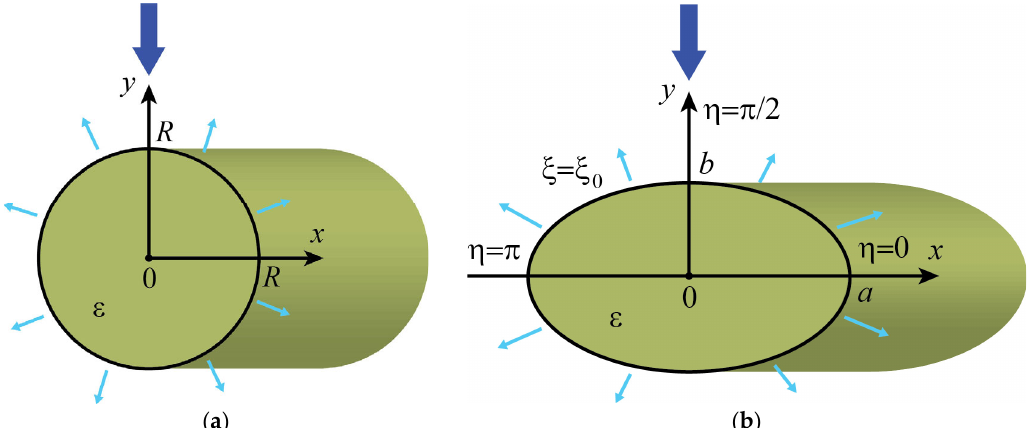
Figure 1. The geometry of the problem. ( a ) Cross-section of a dielectric circular waveguide, and ( b ) a dielectric waveguide with an elliptical cross-section. The waveguide axis coincides with the Cartesian z ‐ axis. The large arrows symbolize incident radiation, and the small arrows denote scattered fields.